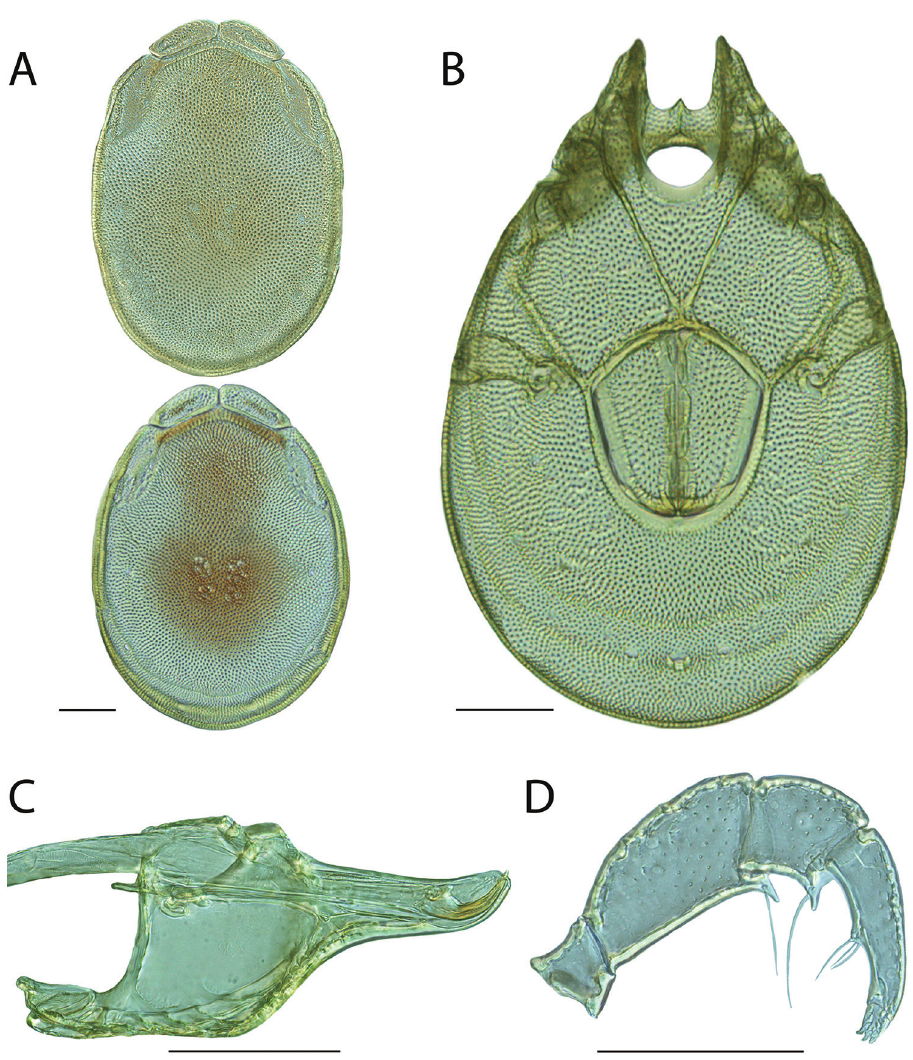
Figure 271. Torrenticola walteri sp. n. female: A dorsal plates, note color variation B venter (legs removed) C subcapitulum D pedipalp (setae not accurately depicted). Scale = 100